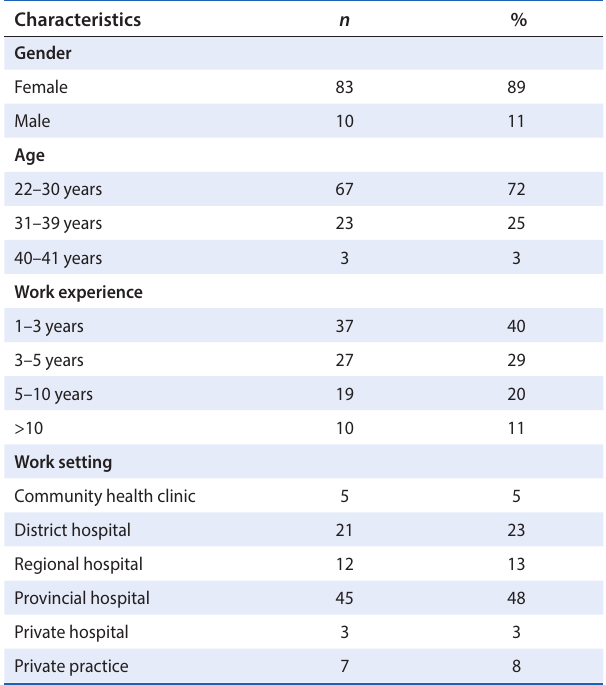
Table 1: Demographic profile ( n = 93) Characteristics